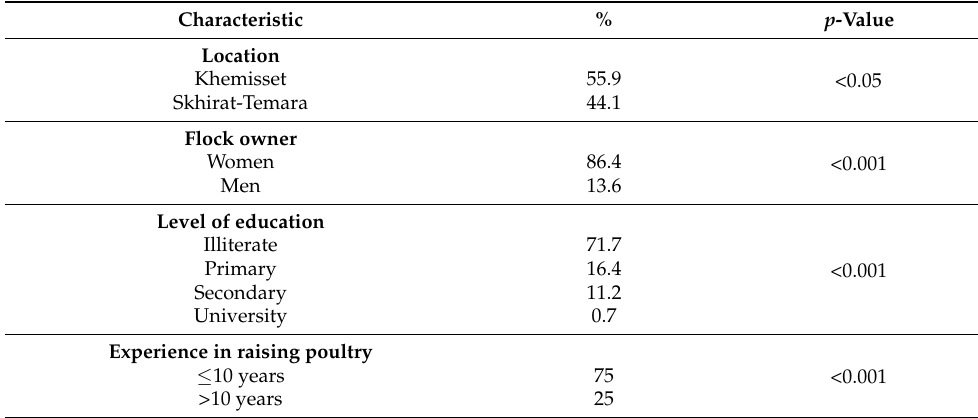
Table 1. Percentage of backyard flock characteristics as reported by flock owners.